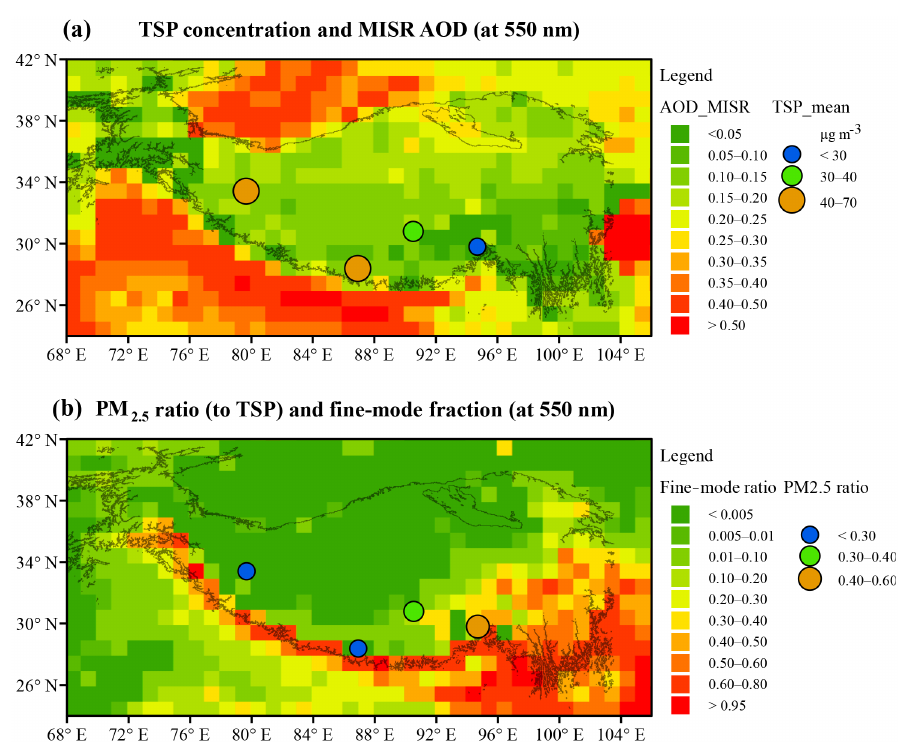
Figure 11. Spatial patterns in AOD and TSP mass (a) and aerosol fine-mode fraction and the ratio of PM 2 . 5 to TSP (b) over the HTP. (a) Mean MISR AOD (at 550nm) for 2011–2013 as derived from monthly Level 3 datasets. (b) A time-average map of the MODIS fine- mode fraction (at 550nm) for 2011–2013, according to monthly Terra (version 5.1) Level 3 values. Ground-based observations are average values sampled in